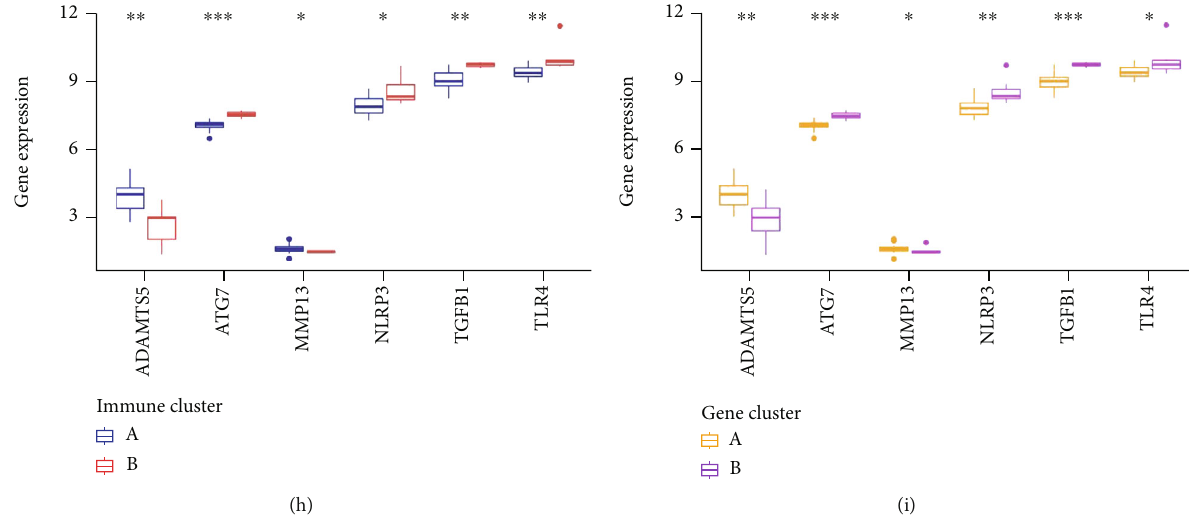
Figure 7: (a) Consensus matrices of the 220 DEGs. (b) Di ff erential expression histogram of the 11 IEGs in gene cluster A and B. (c) Di ff erential immune cell in fi ltration among gene cluster A and B. (d) PCA for gene cluster A and B. (e) Di ff erences in immune score between immune cluster A and B. (f) Di ff erences in immune score between gene cluster A and B. (g) The Sankey diagram of relationship between immune patterns, gene patterns, and immune scores. (h) Di ff erential expression levels of the ADAMTS, ATG7, MMP13, NLRP3, TGFB1, and TLR4 among immune cluster A and B. (i) Di ff erential expression levels of the ADAMTS, ATG7, MMP13, NLRP3, TGFB1, and TLR4 among gene cluster A and